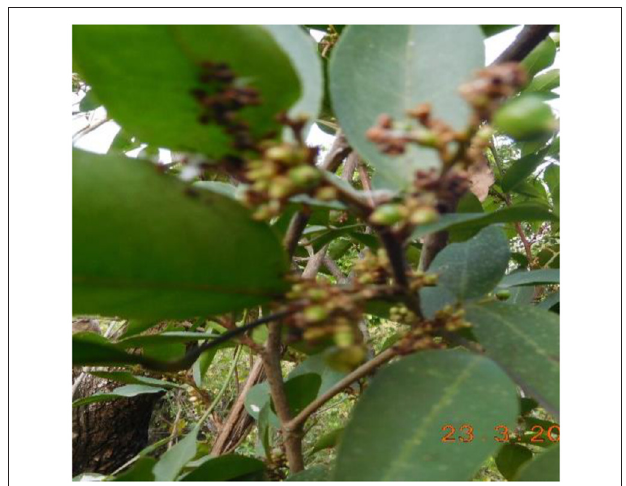
FIGURE 1 | A close view of Glycosmis pentaphylla